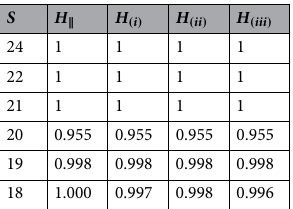
Table 3. The overlaps � ( [ 7 ] χ) S | � S ,1 � (denoted as 7+1 in short) of H (cid:31) with N = 8 and f = 3 , where (cid:31) S ,1 is an eigen-b-state of H ( z ) ( z = i , ii , and iii ) lying in Zone I.